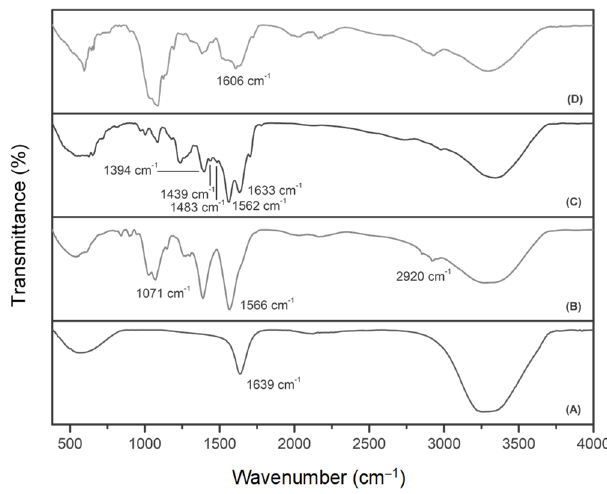
Figure 2. FTIR spectra of ( A ) AuNPs, ( B ) Au-CS, ( C ) Au-CS-His and ( D ) Au-CS-FA-His. High-resolution transmission electron microscopy (HRTEM) was utilized to visualize the ultrastructural characteristics of the NPs and are represented in Figure 3. The aggregation (Figure 3D).